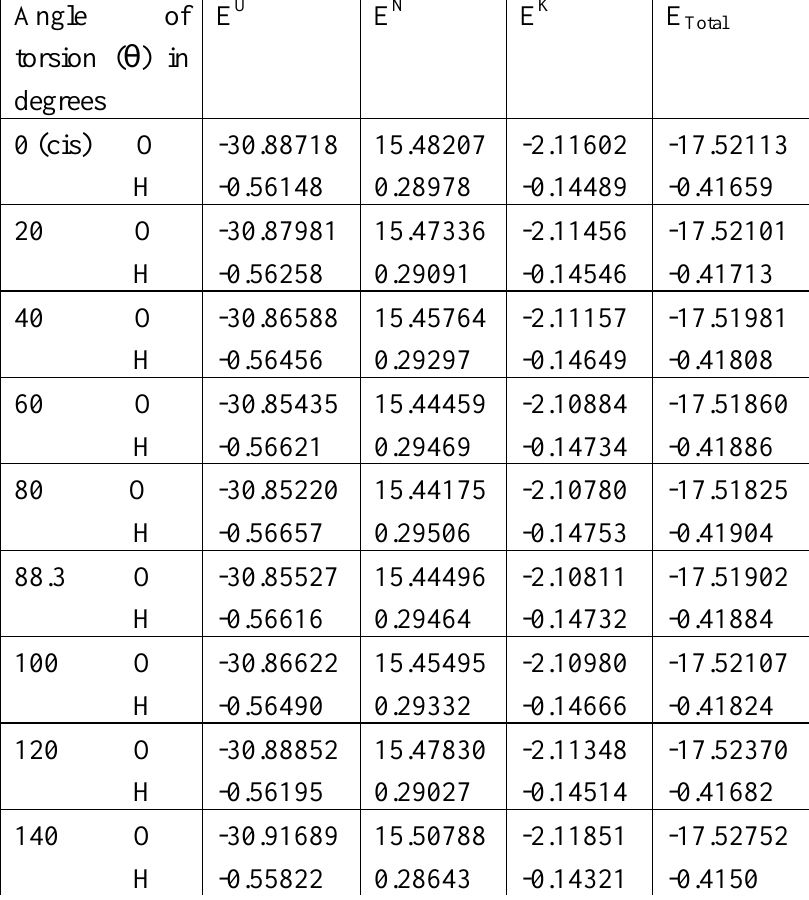
Table 7. The Partitioned components of one-center energies (a.u) on O and H atoms in Hydrogen Peroxide with